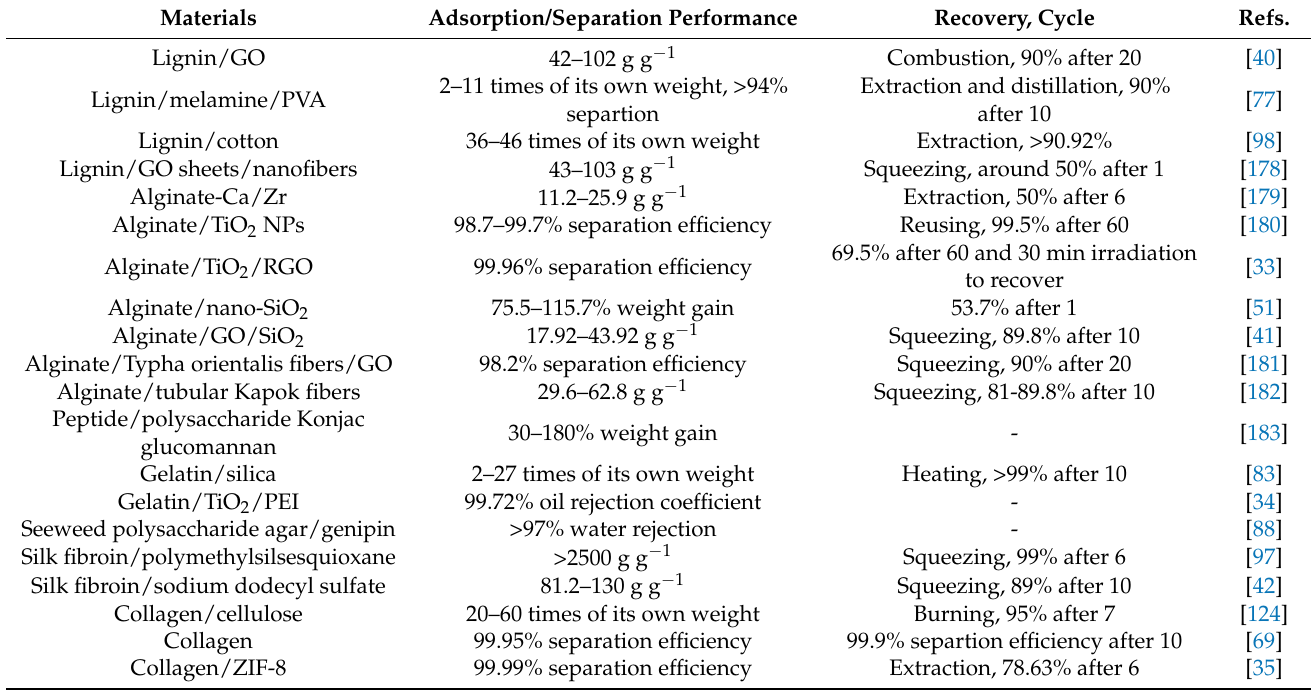
Table 7. Other biomass based sorbents for spill oil